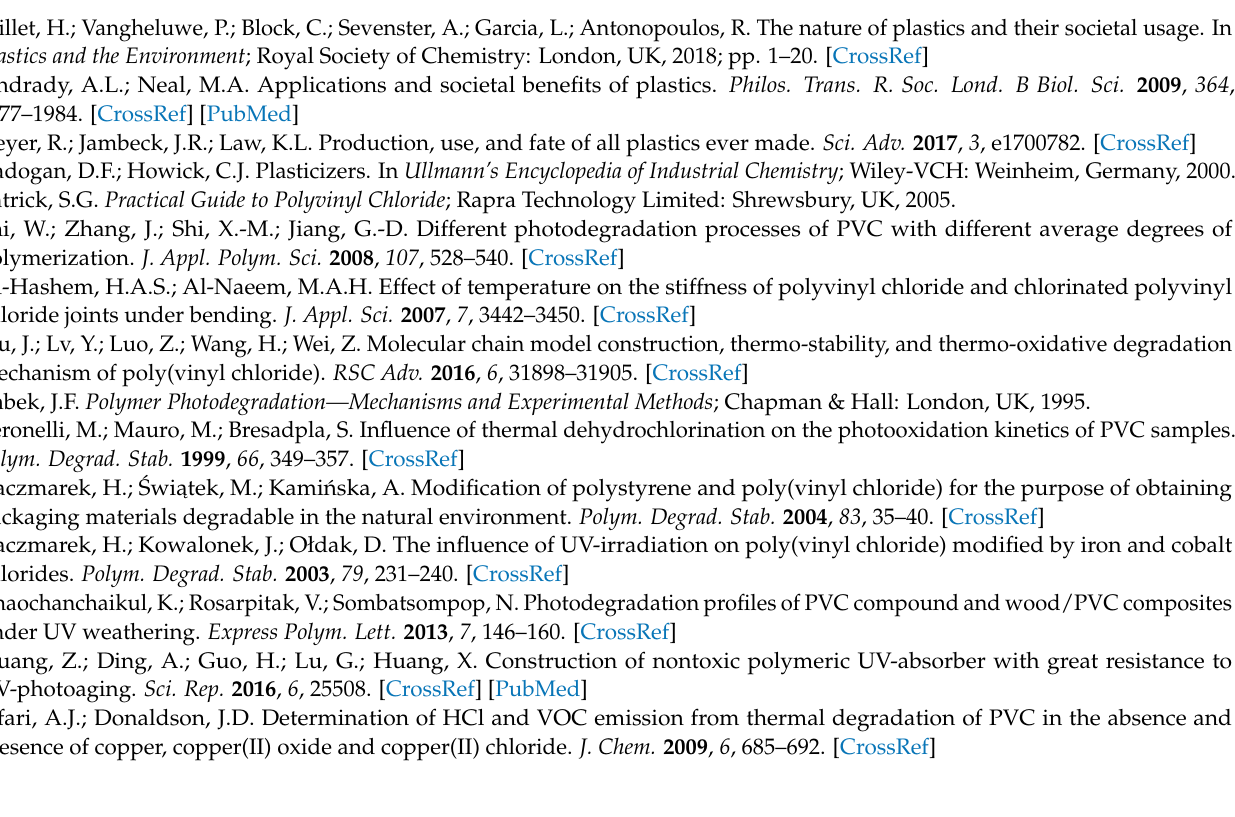
Figure S3: FTIR spectrum of 2 ; Figure S4: FTIR spectrum of 3 ; Figure S5: 119 Sn NMR spectrum of 1 ; Figure S6: 119 Sn NMR spectrum of 2 ; Figure S7: 119 Sn NMR spectrum of 3 ; Figure S8: EDX